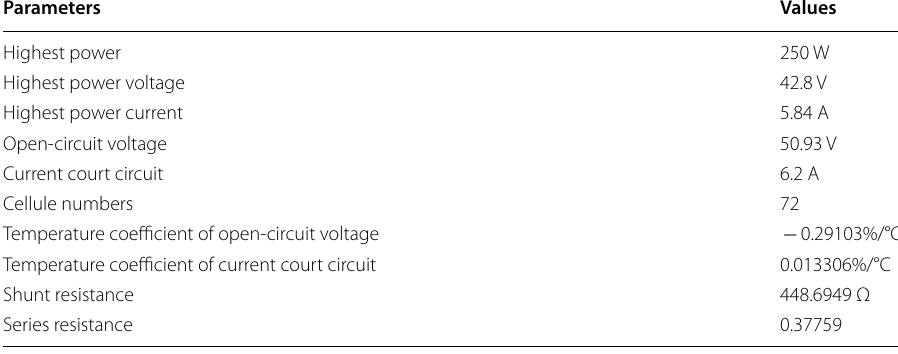
Table 2 Characteristics of (Sun Power SPR-250NX-BLK-D) PV model